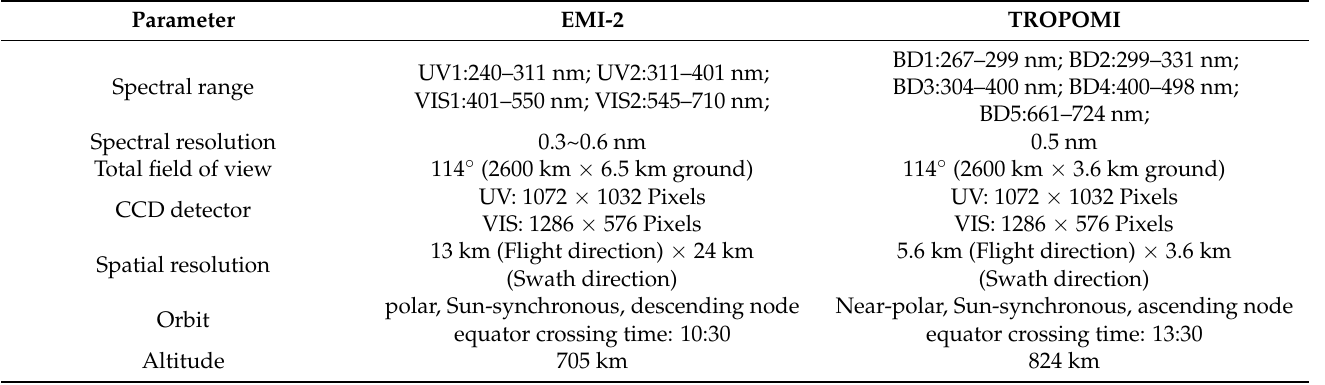
Table 1. The comparison of parameters of EMI-2 and